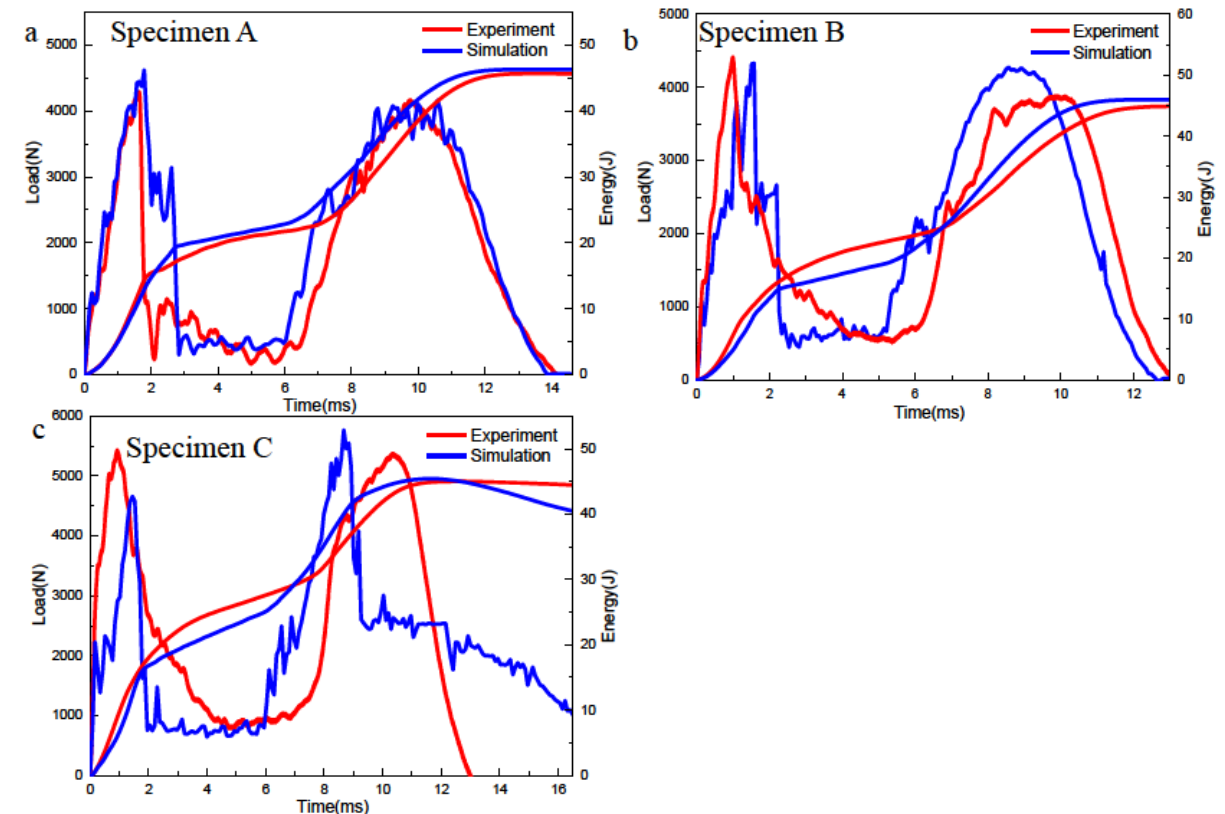
Figure 8: Response of specimens impacted under the impact energy of 45 J.